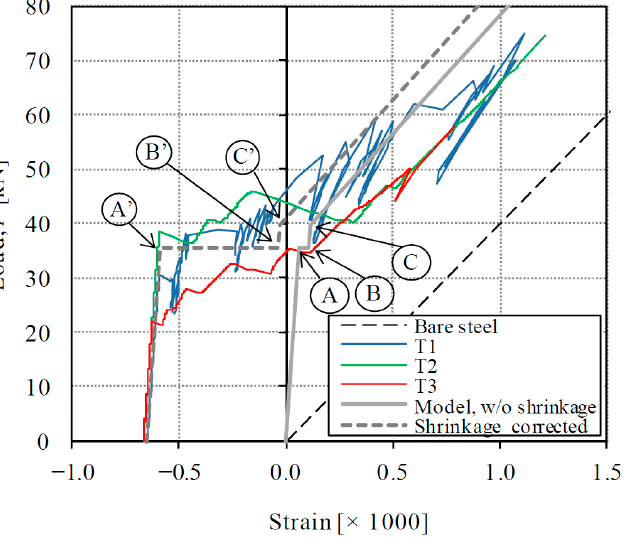
Figure 14. Comparison of experimental results with composite tension chord model corrected with shrinkage effect